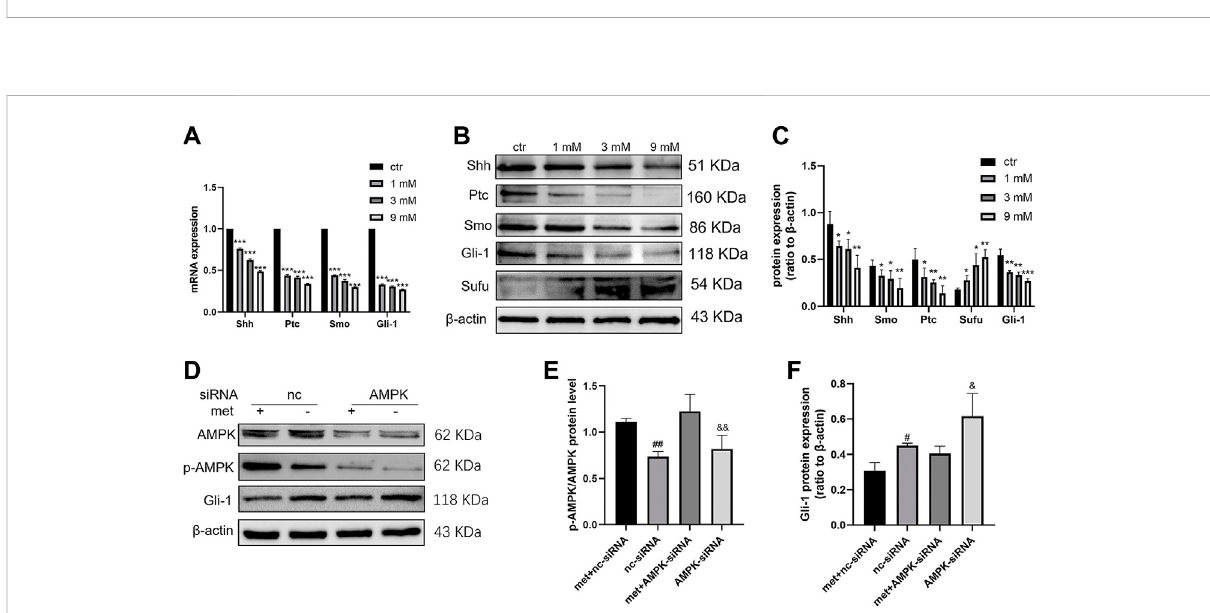
FIGURE 5 Metformin inhibited the expression of the Shh signaling pathway in Daoy cells. (A) The mRNA levels of Shh, Smo, Ptc, and Gli-1 were analyzed using quantitative PCR after 24 h of metformin treatment; GAPDH served as a control (n = 3, t-tests were used to determine the signi fi cance). (B,C) The protein levels of Shh, Smo, Ptc, Sufu, and Gli-1 were analyzed using western blot analysis after metformin treatment, β -actin served as a control ( n =4,t-testswereusedtodeterminethesigni fi cance). (D – F) TheproteinlevelsofAMPK,p-AMPK(Thr172),andGli-1wereanalyzedbywestern blotafterAMPKsiRNAandmetformin(3 mM)treatmentfor24 h, β -actinservedasacontrol( n =3,one-wayANOVAmultiplecomparisonswereused todeterminethesigni fi cance).Dataarepresentedasthemean±SD.* p < 0.05;** p < 0.01;*** p < 0.001comparedwiththecontrolgroup.# p < 0.05; ## p < 0.01 compared with the met + nc-siRNA group. P < 0.05; and p < 0.01 compared with the met + AMPK-siRNA